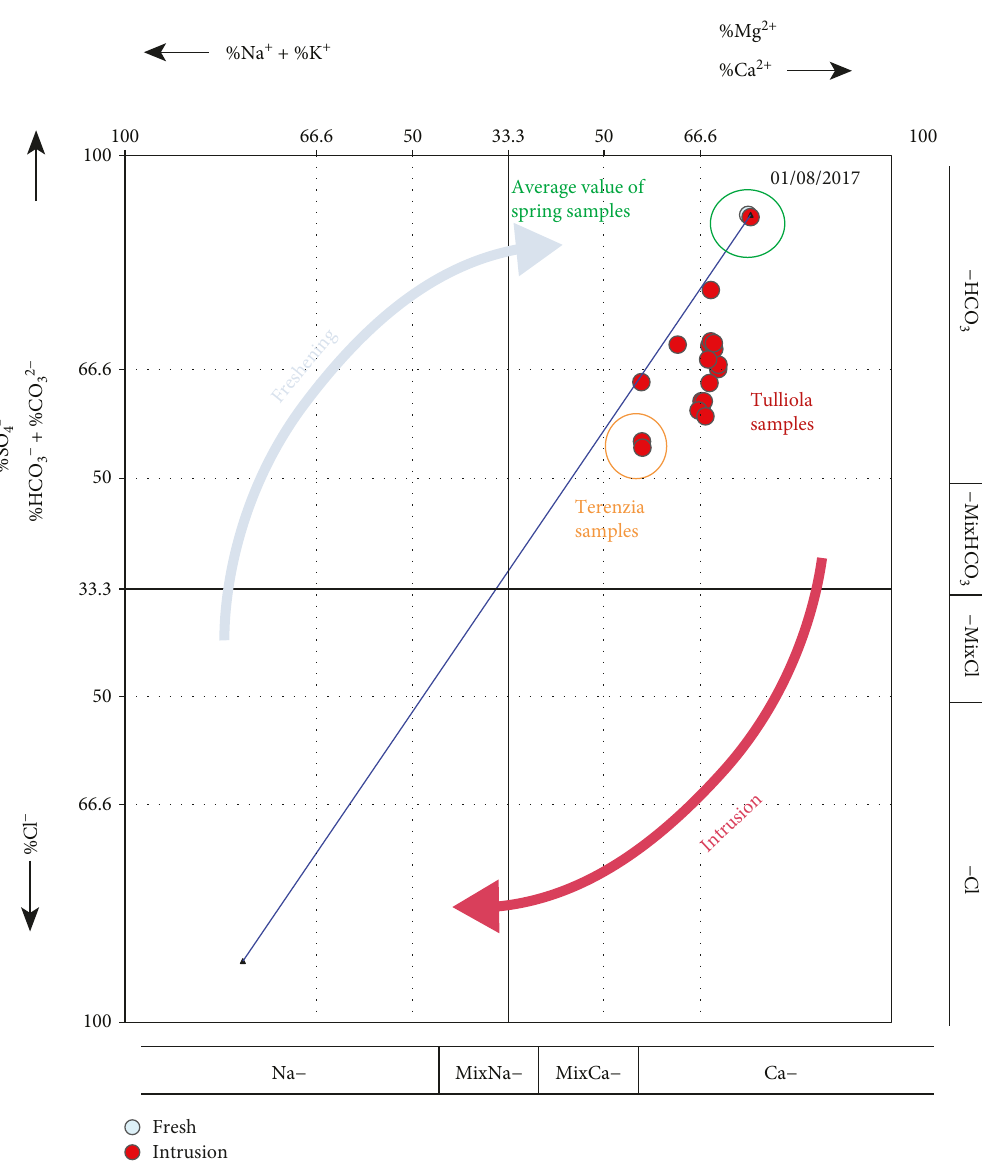
Figure 14: Hydrochemical Facies Evolution Diagram (HFE-D) for groundwater